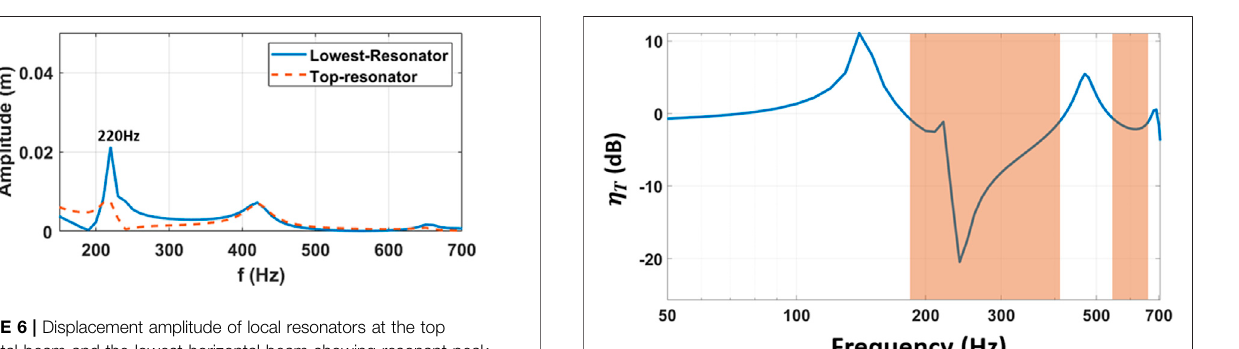
FIGURE 6 | Displacement amplitude of local resonators at the top horizontal beam and the lowest horizontal beam showing resonant peak around220 Hz,close totheoverallresonant peakoftheunit cell, F n (cid:1) 224Hz.